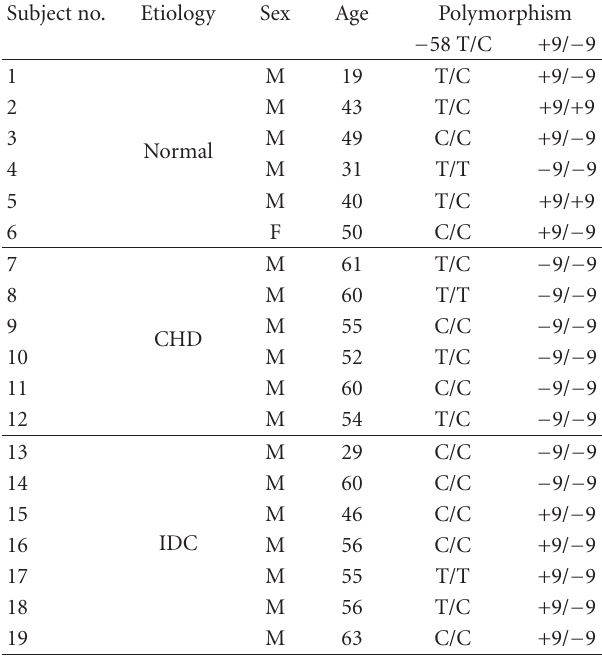
Table 1: BK-2R polymorphism in human hearts. The presence of two BK-2R gene polymorphisms, − 58T/C and − 9/+9, was analyzed in normal and failing human hearts according to the protocol described in Section